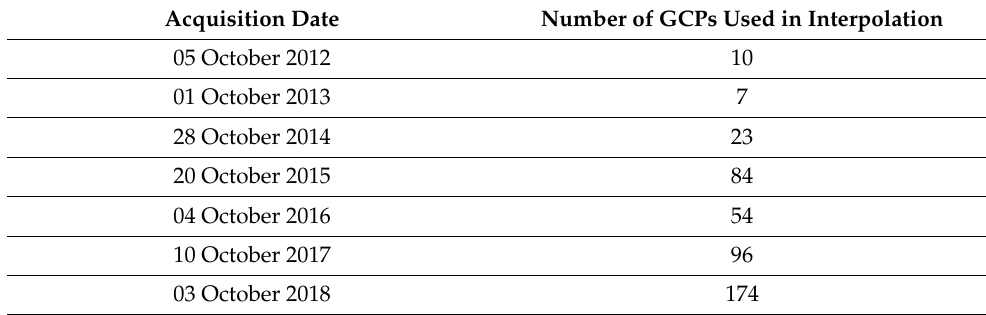
Table 2. Acquisition date and number of theodolite-generated ground control points (GCPs).